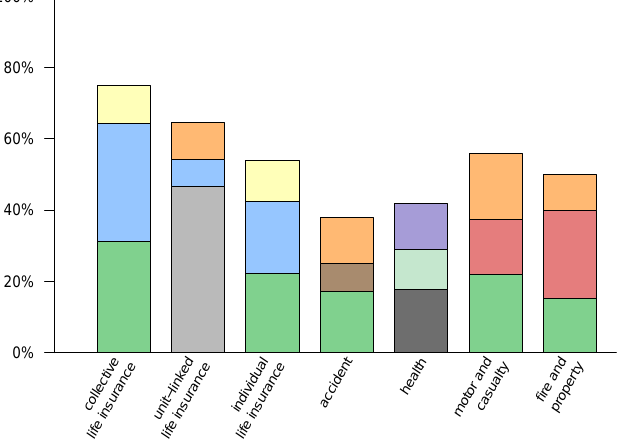
Figure 1. Market shares based on earned premiums of the three largest Swiss insurers in selected lines of business in year 2014, see [3]. The values shown are additive and different colors reflect different insurers/groups.